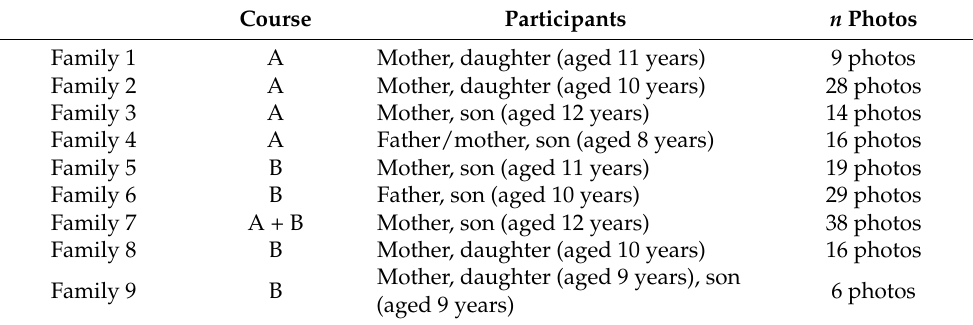
Table 2. Participating